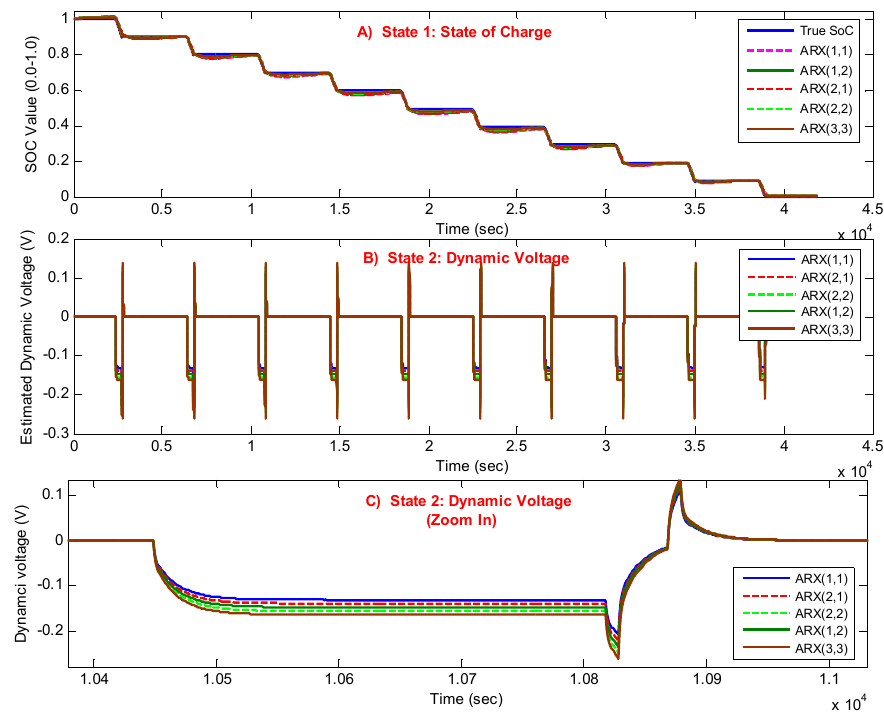
Figure 18. SOC estimation profiles based on HPPC cycles with .